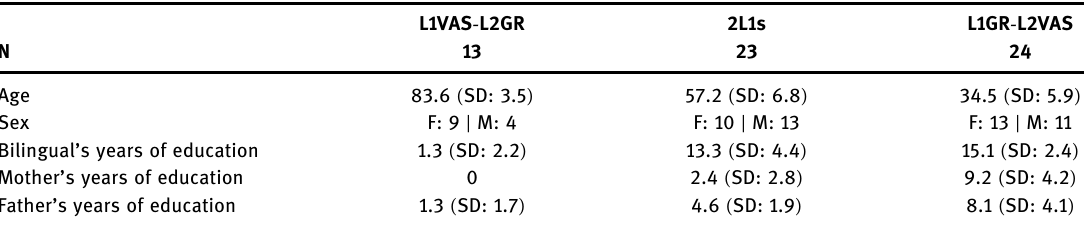
Table 2: Ethnographic and educational background data per bilingual